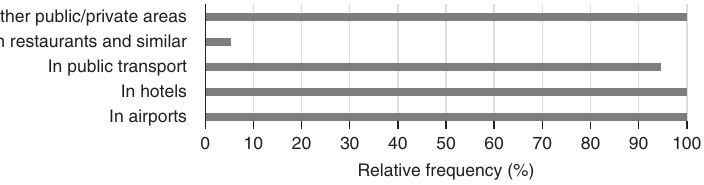
Figure 3. Frequency